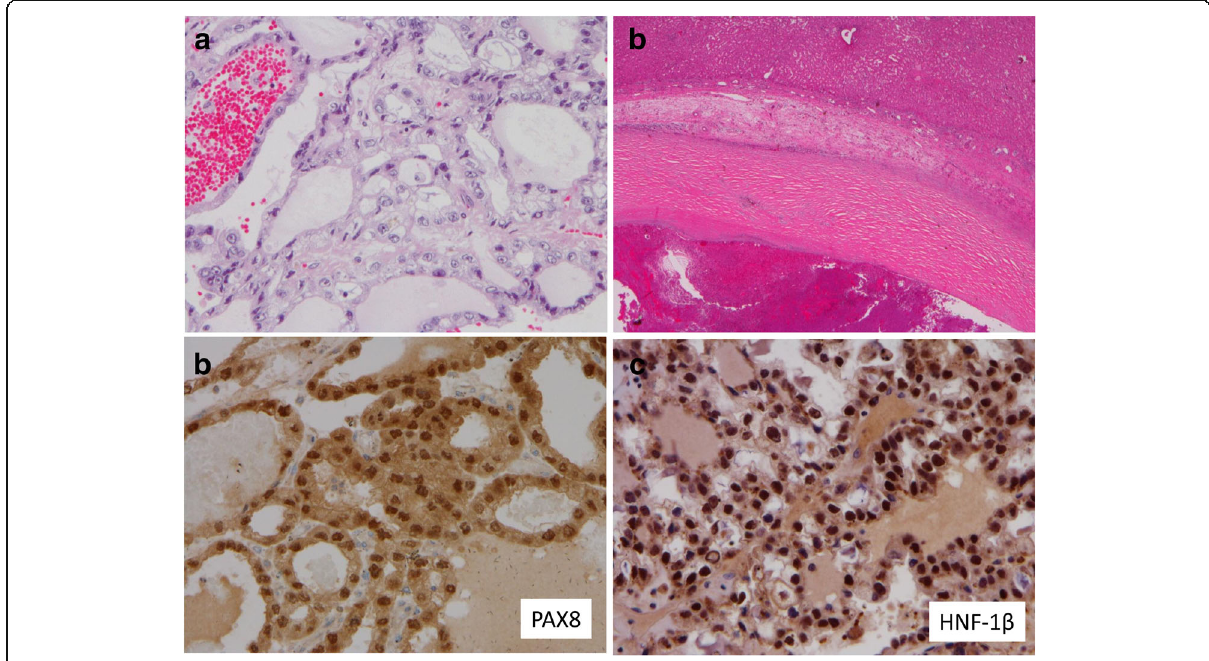
Fig. 2 Histopathological findings. a The tumor has ductal structure including mucin and atypical nuclear with clear cytoplasm (H&E stain). b The tumor was separated from the liver and the diaphragm. c The expression of Pax8 was positive. d The expression of HNF1 β was positive. H&E, hematoxylin and eosin; Pax8, paired box gene 8; HNF1 β , hepatocyte nuclear factors 1